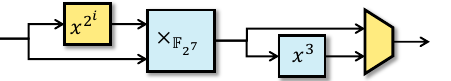
Figure 3: Efficient implementation of the 7-bit quadratic power maps x 5 or x 9 together with their inverse. The linear block can evaluate either x 4 or x 8